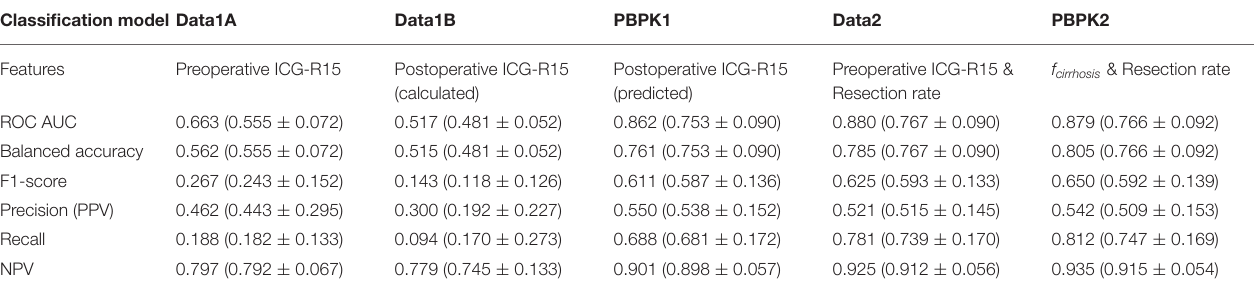
TABLE 3 | Evaluation metrics for classification models of survival after hepatectomy. Classification model